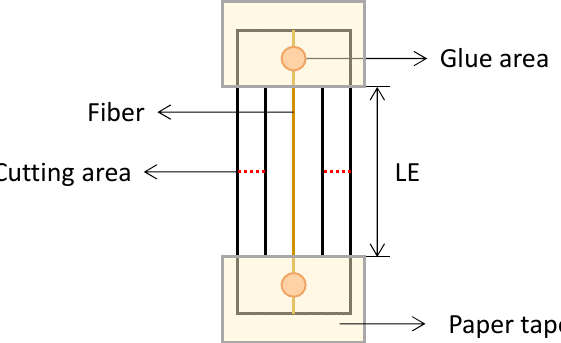
Figure 2. Schematic drawing of a fiber mounted in a paper frame for a tensile test.